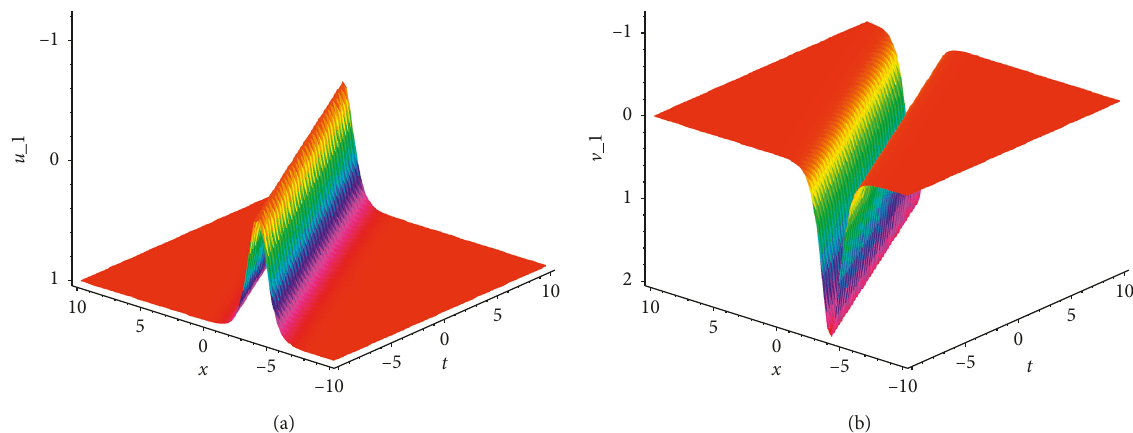
Figure 1: Plots of two line solitons expressed by equations (34a)–(34b) for solution of the nKdV equation (1) with the parameters a � ε � c � k � 1 1 1